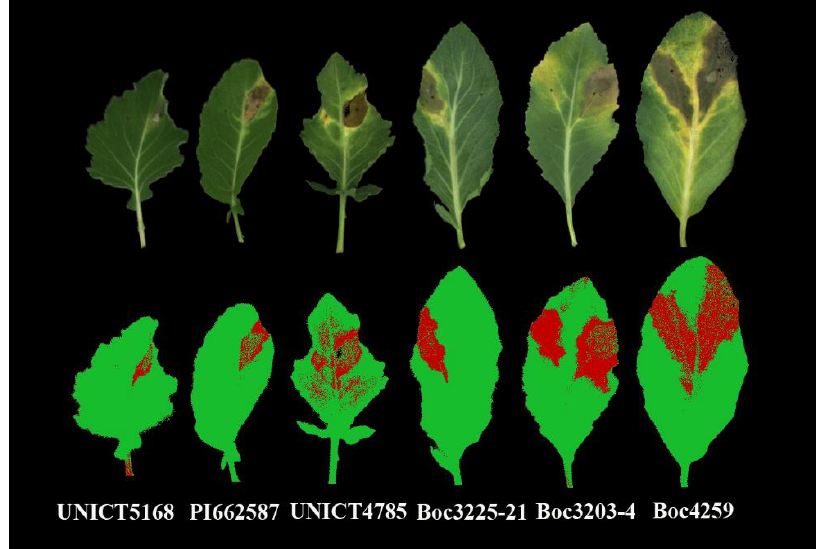
Figure 2. The severity of symptoms on leaves of different accessions 10 days after inoculation with the Xcc 4 bacterial suspension. (upper row, photos under ordinary brightfield lighting; bottom row, photos analyzed by the PPMS).